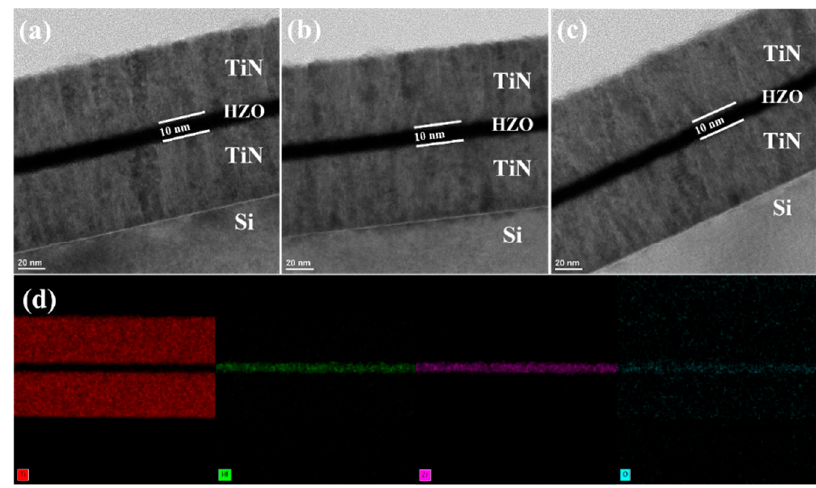
Figure 5. The transmission electron microscopy (TEM) image of the TiN/HZO/TiN capacitor, which was fabricated at three different chamber temperatures: ( a ) 120 °C, ( b ) 200 °C, and ( c ) 250 °C. ( d ) The energy-dispersive spectroscopy (EDS) images for titanium, hafnium, zirconium, and oxygen in the HZO capacitor at the chamber temperature of 250 °C. Table 1. Energy-dispersive spectrometer (EDS) quantification of elements in HZO layer.